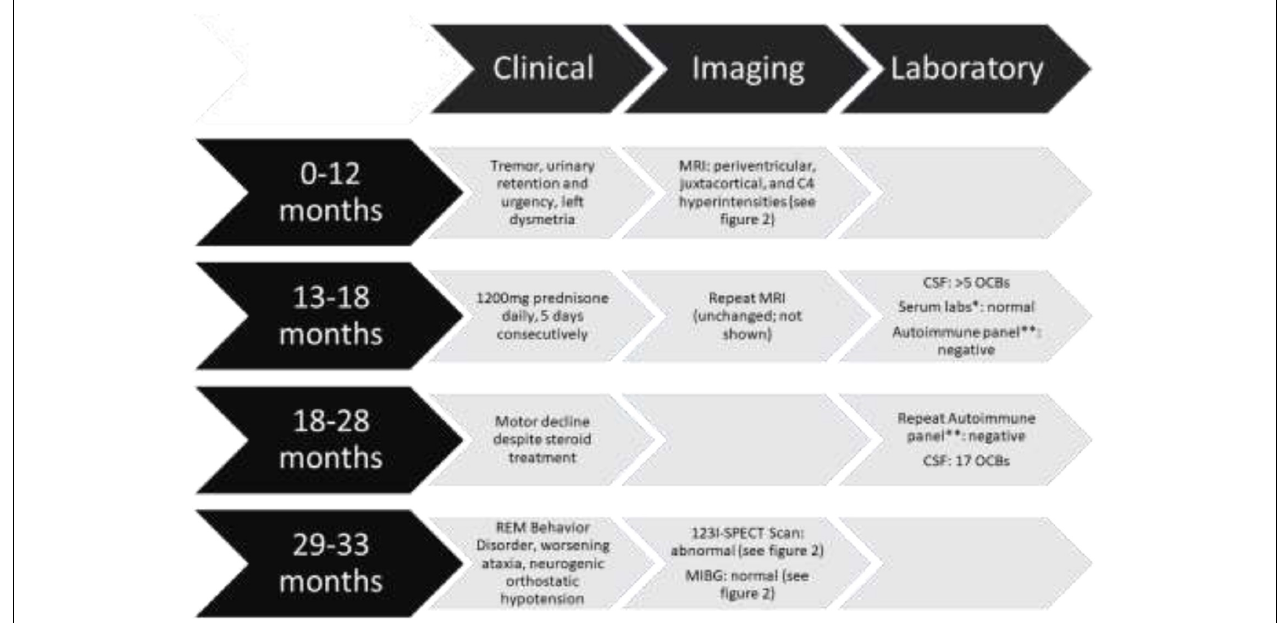
FIGURE 1 | Timeline of events including clinical, imaging, laboratory findings and interventions *Serum labs included vitamin B1, B12, E, copper, zinc, thyroid-stimulating hormone (TSH), hepatitis B, antinuclear antibody (ANA), antineutrophil cytoplasmic antibody (ANCA), and tissue transglutaminase. All were reported within normal limits. **Autoimmune panel included: amphiphysin, AGNA-1, ANNA-1, ANNA-2, ANNA-3, CASPR2, CRMP-5, DPPX, GAD65, GRAF1, IgLONS, ITPR1, LGI1, mGluR1, NIF, NMDA, PCA-Tr, PCA-1, PCA-2 antibodies which were reported as “negative” except GAD65 which was reported as 0.00